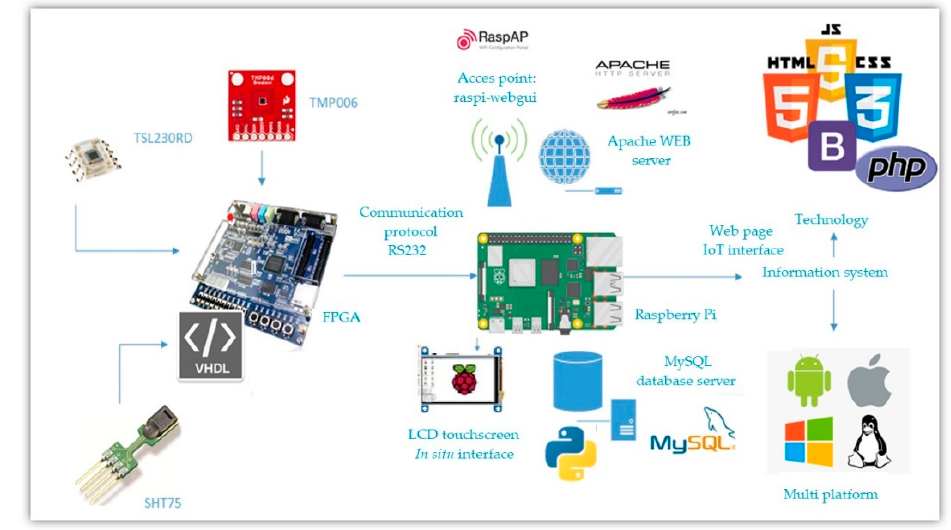
Figure 14. IoT system general connection diagram.